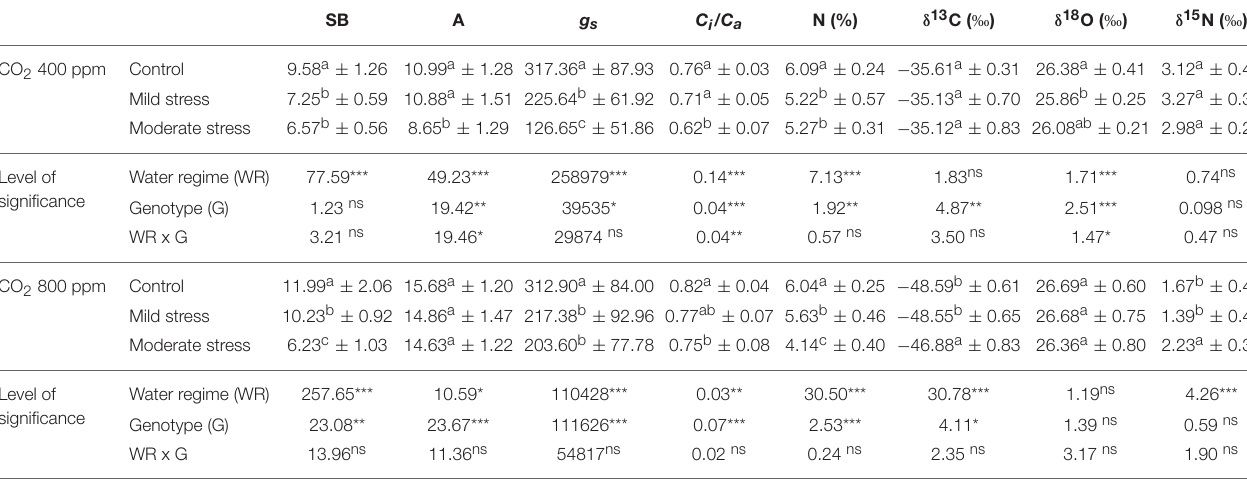
TABLE 3 | Effect of water regime treatments in each CO 2 concentration (400 and 800 ppm) on shoot biomass, gas-exchange parameters, nitrogen content, and carbon, oxygen, and nitrogen stable composition.